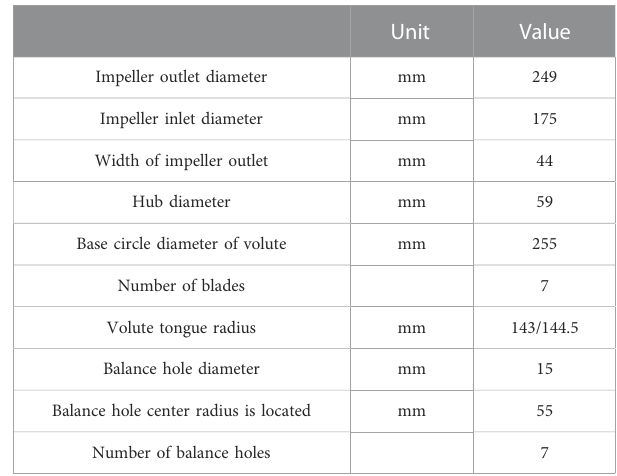
TABLE 1 Geometric dimensions of the CMP.